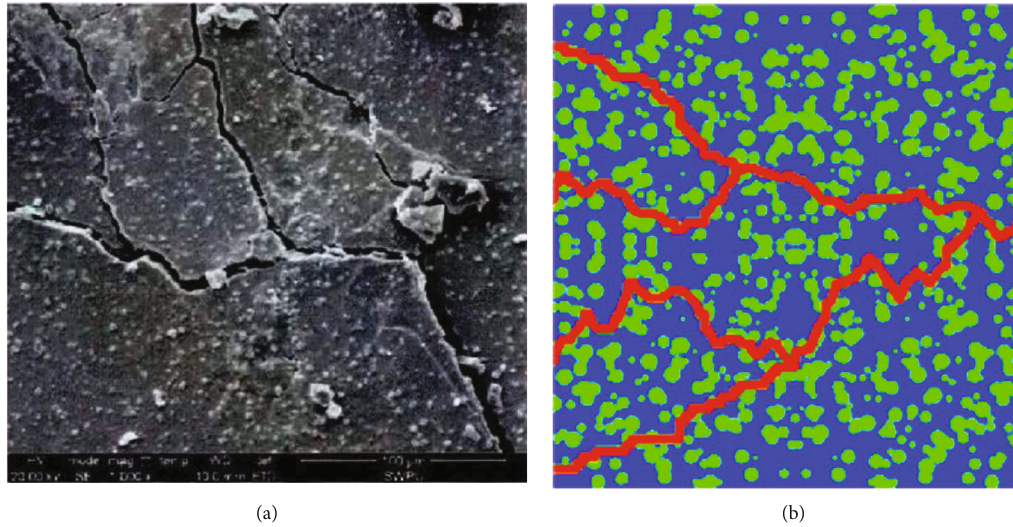
Figure 2: Schematic diagram of coal and the 2D reconstructed